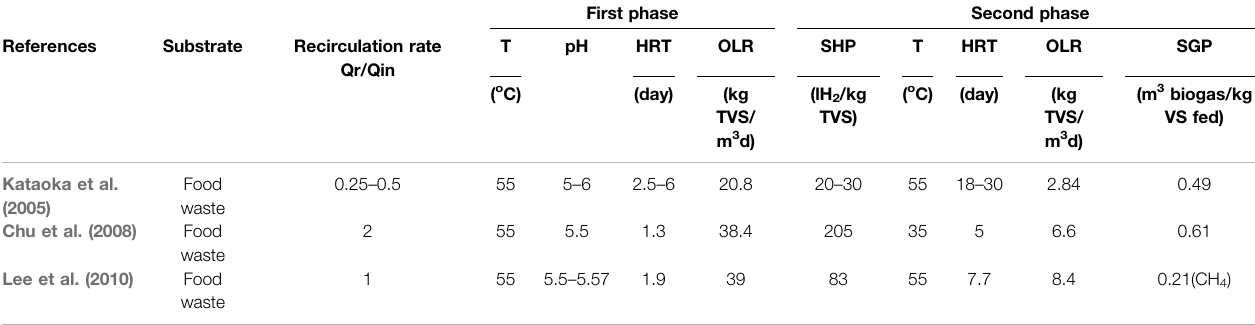
TABLE 3 | The affect of changing the recirculation rate on the two-stage dark fermentation coupled with anaerobic